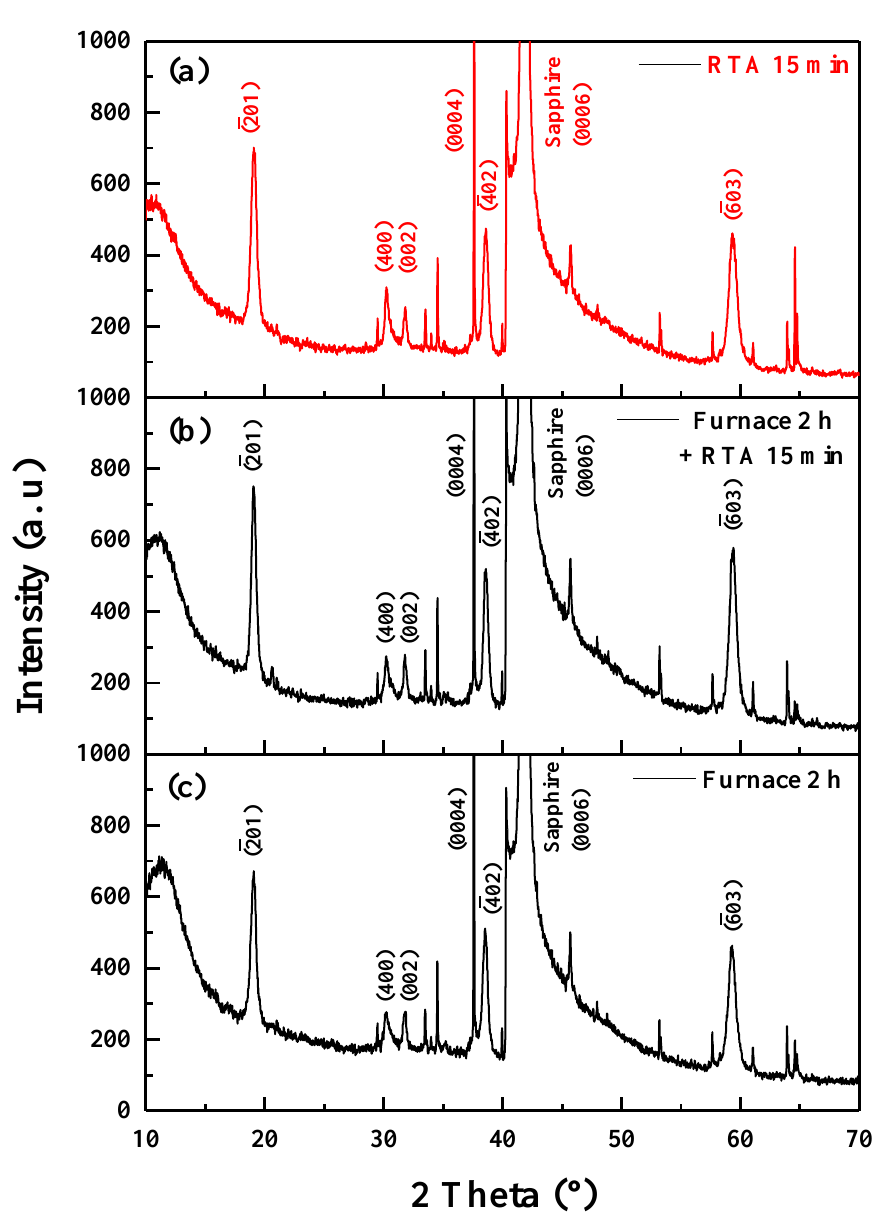
β -Ga 2 O 3 thin films proceeded at various annealing